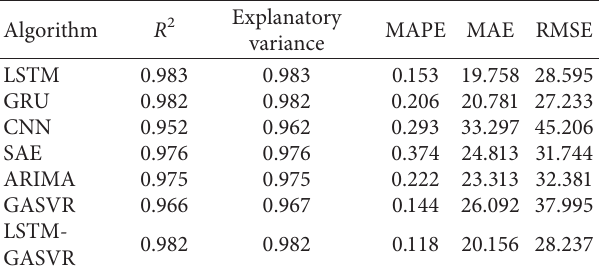
Table 6: Comparison of short-term traffic flow prediction effect of different prediction algorithms.